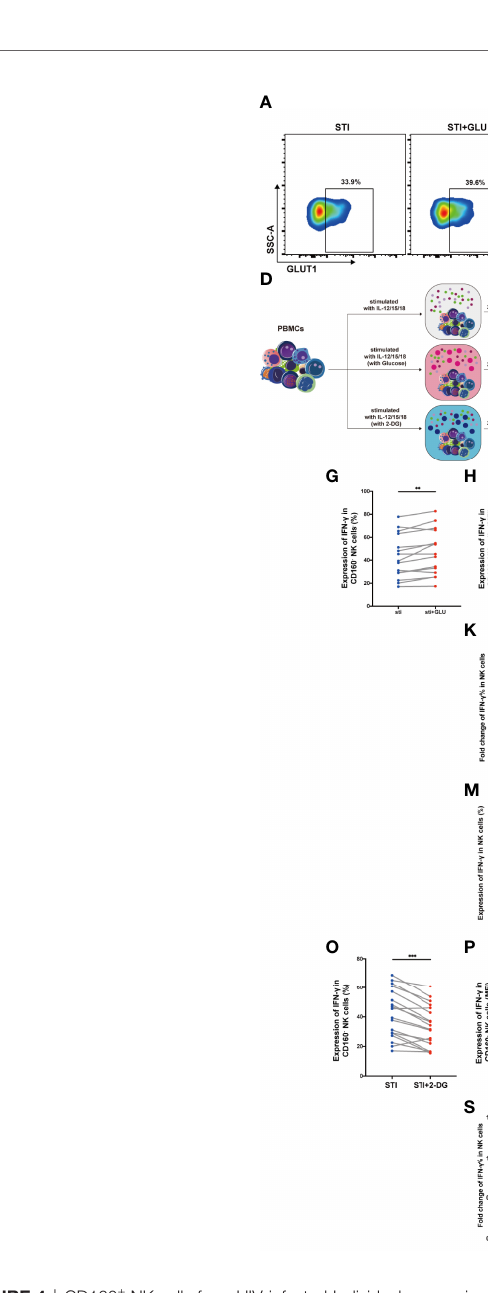
FIGURE 4 | CD160 + NK cells from HIV-infected Individuals were signi fi cantly in fl uenced by addition of glucose or glycolysis inhibition. (A) Representative dot plots of GLUT1 expression on total NK cells from HIV-infected individuals was measured by fl ow cytometry after 24 h of cytokines stimulation (10 ng/ml IL-12 + 50 ng/ml IL-15 + 100 ng/ml IL-18) with or without additional 10 mmol/L glucose. Corresponding statistical analysis of the percentage (B) and MFI (C) of GLUT1 on NK cells (n = 10). (D) Schematic diagram of experiments using PBMCs treated with IL-12 + IL-15 + IL-18 (10, 50 and 100 ng/ml, respectively) alone, additional glucose (10 mmol/L) or 2-DG (5 mmol/L) to study effects on IFN- g production in total NK cells from HIV-infected individuals. (E, F) Corresponding statistical analysis of the percentage (E) and MFI (F) of IFN- g in total NK cells from HIV-infected individuals with or without additional glucose (10 mmol/L) (n = 15). (G – J) Paired comparison of the percentage (G, I) and MFI (H, J) of IFN- g in CD160 - or CD160 + NK cells from HIV-infected individuals with or without additional glucose (10 mmol/L) (n = 15). (K, L) Fold changes of the percentage (K) and MFI (L) of IFN- g expression were calculated as the treatment with additional glucose (10 mmol/L) over the treatment without additional glucose in CD160 - as well as CD160 + NK cells from HIV-infected individuals (n = 15). (M, N) Percentage (M) and MFI (N) of IFN- g expression in total NK cells with or without 2-DG treatment (5 mmol/L) (n = 18). (O – R) Paired comparisons of the percentage (O, Q) and MFI (P, R) of IFN- g in CD160 - or CD160 + NK cells with or without additional 2-DG treatment (5 mmol/L) (n = 18). (S, T) Fold changes of percentage (S) and MFI (T) of IFN- g expression were calculated as the treatment with additional 2-DG treatment (5 mmol/L) over the treatment without 2-DG in CD160 - as well as CD160 + NK cells from HIV-infected individuals (n = 18). The mean fl uorescence intensity of GLUT1 and IFN- g in (C, F, N) was from total NK cells. And the mean fl uorescence intensity of IFN- g in (H, P, J, R) was from CD160 - and CD160 + NK cells, respectively. The fold change of IFN- g MFI in panels (L, T) was from CD160 - and CD160 + NK cells, respectively. A Wilcoxon matched-pairs signed-rank test was employed for paired-group comparisons. A Spearman ’ s rank test was applied for correlation analysis; * P < 0.05; ** P < 0.01; *** P < 0.001; **** P < 0.0001; ns, no signi fi cance. Data are represented as means ±